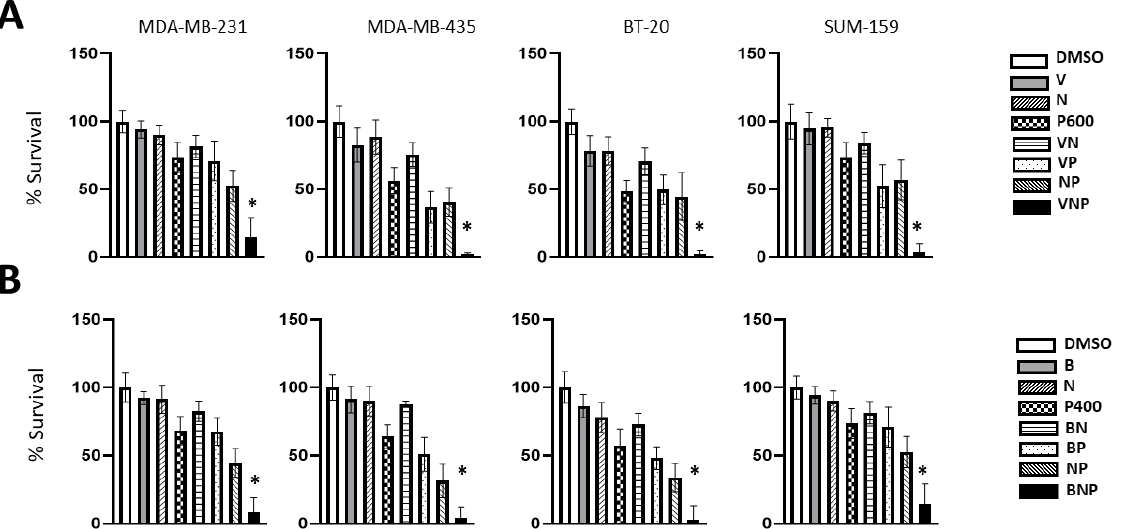
Figure 3. Triple-negative breast carcinoma; the combination of HDAC-i Vorinostat or Belinostat (B), with Niclosamide (N) and HSP90-i Pimitespib (P). The TNBC cell lines BT20, MDA-MB-231, MDA- MB-435 and Sum159 are cultured in 96-well plates for 7 days with indicated drugs. The